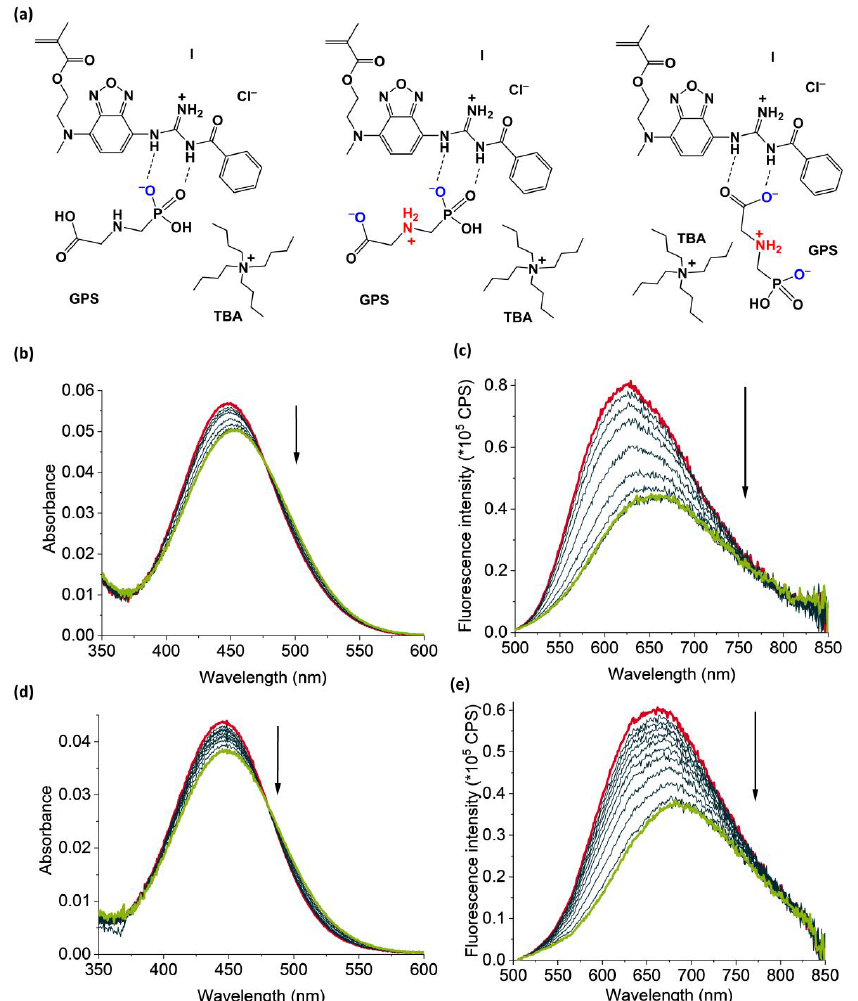
Figure 1. ( a ) Proposed major (left) and other possible (middle, right) species of GPS-TBA and the respective hydrogen bonding interactions between I and GPS-TBA in organic solvents; color code as in Scheme 1. ( b ) Absorption and ( c ) fluorescence emission spectra ( λ ex = 474 nm) of I (6.5 µ M) upon titration with GPS-TBA in CHCl 3 (0.6–9.2 µ M). The red line is the spectrum of I in CHCl 3 , while the green line shows the spectrum of I after the addition of 1.4 equivalents of GPS-TBA. ( d ) Absorption and ( e ) fluorescence spectra ( λ ex = 483 nm) upon titration of I (6.5 µ M) with GPS-TBA in MeCN (0.1–9.9 µ M). The red line is the spectrum of I in MeCN, while the green line shows the spectrum of I after the addition of 1.5 equivalents of